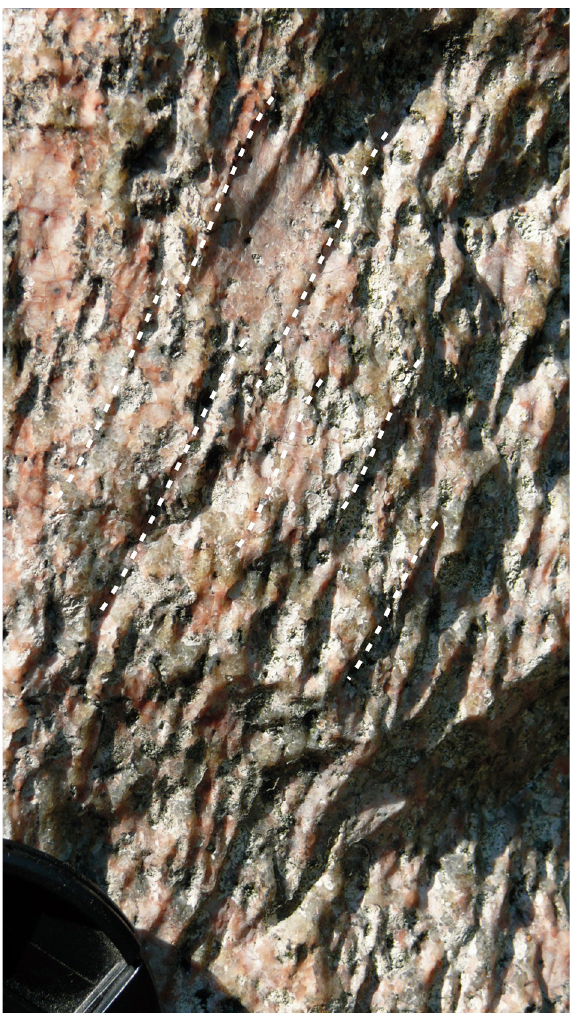
Fig. 10. Rapakivi granite – details of the distinctive structure of this indicator erratic from the Åland Islands; No. 8 in Table 2. Photo by M. Górska- Zabielska